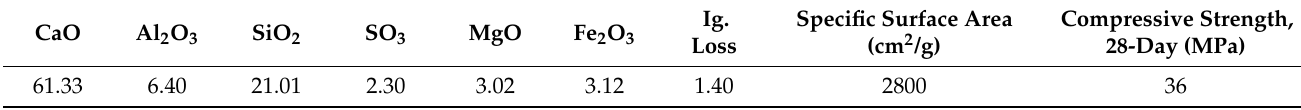
Table 1. Chemical composition and physical properties of the